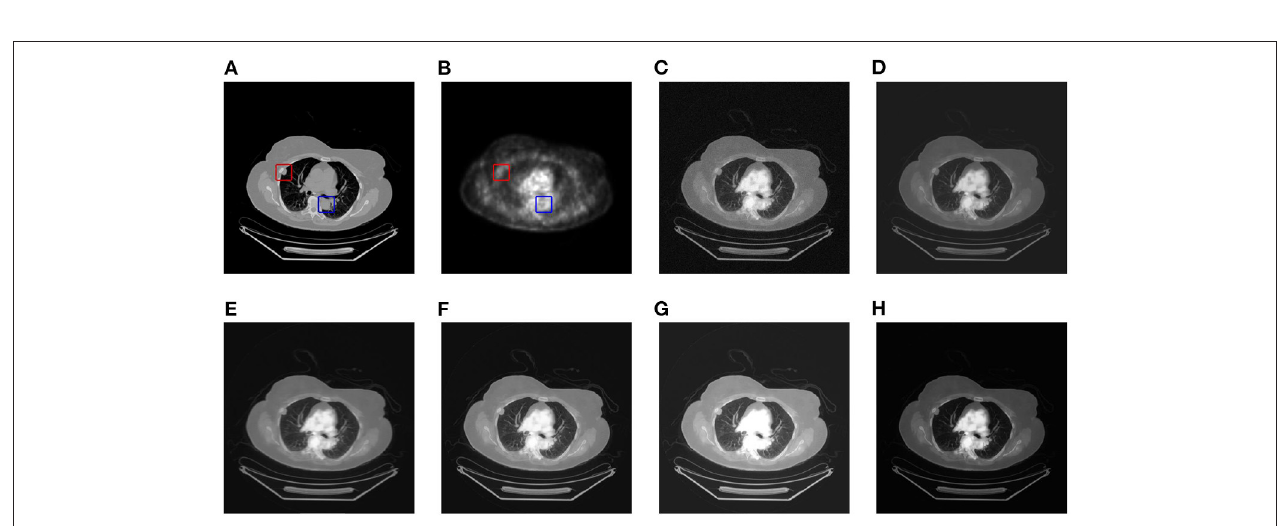
FIGURE 5 | The qualitative comparison results of patient B. (A) CT; (B) PET; (C) AD; (D) GF; (E) PAPCNN; (F) MCFNET; (G) IFCNN; (H) OURS.